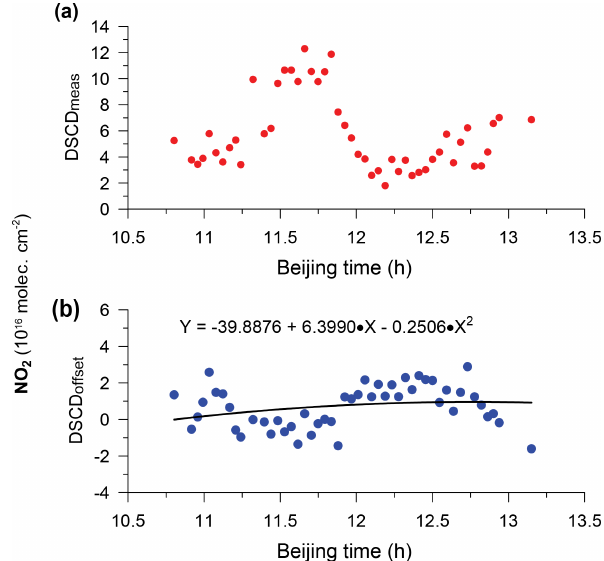
Figure 3. Time series of the NO 2 (a) DSCD means (red dots) and (b) DSCD offset (black dots) (units of 10 16 molec.cm − 2 ) for the 30 ◦ elevation angle of each sequence on 18 January 2014. The black curve represents a second-order polynomial fit from individ- ual DSCD offset data